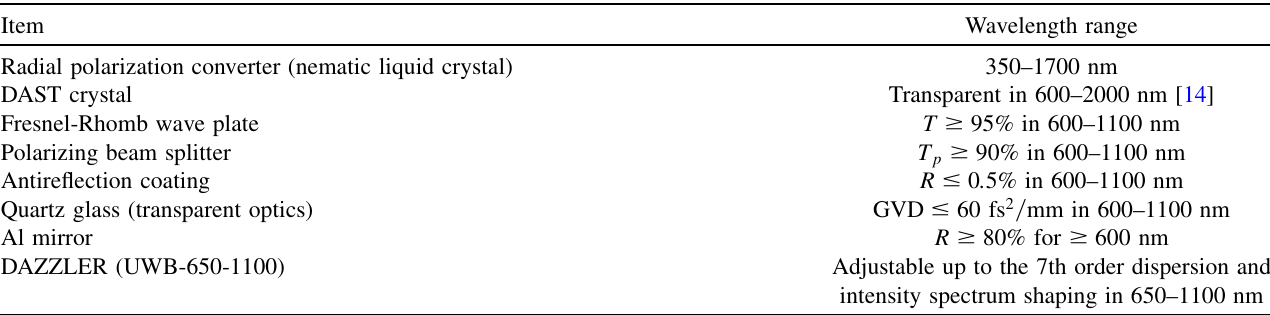
TABLE I. Optical components for super continuum laser pulse: 650–1100 nm.